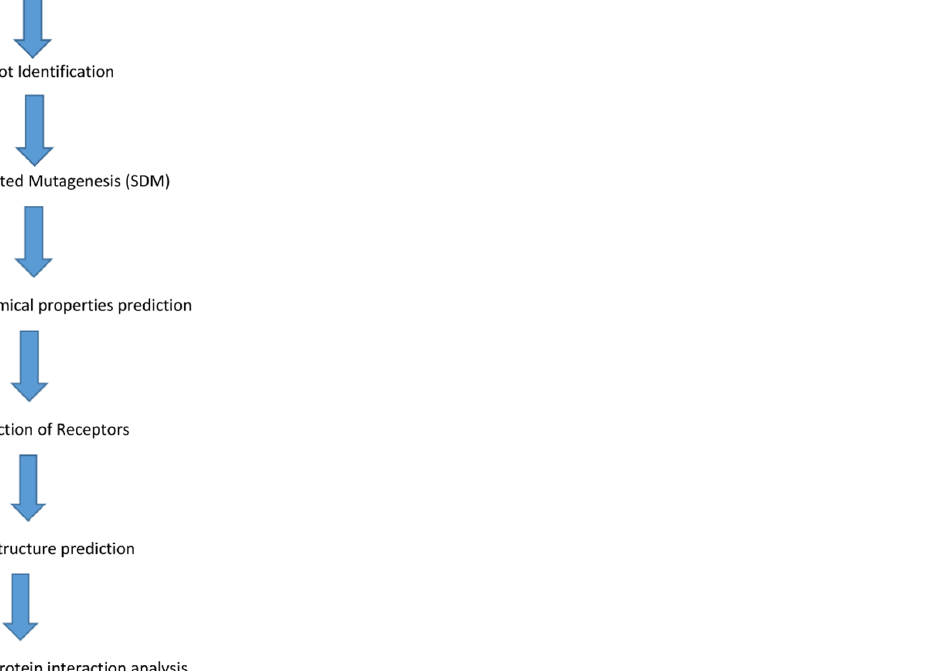
Table 1. Identification of mutation ‐ sensitive amino acid residue hotspots using KFC.